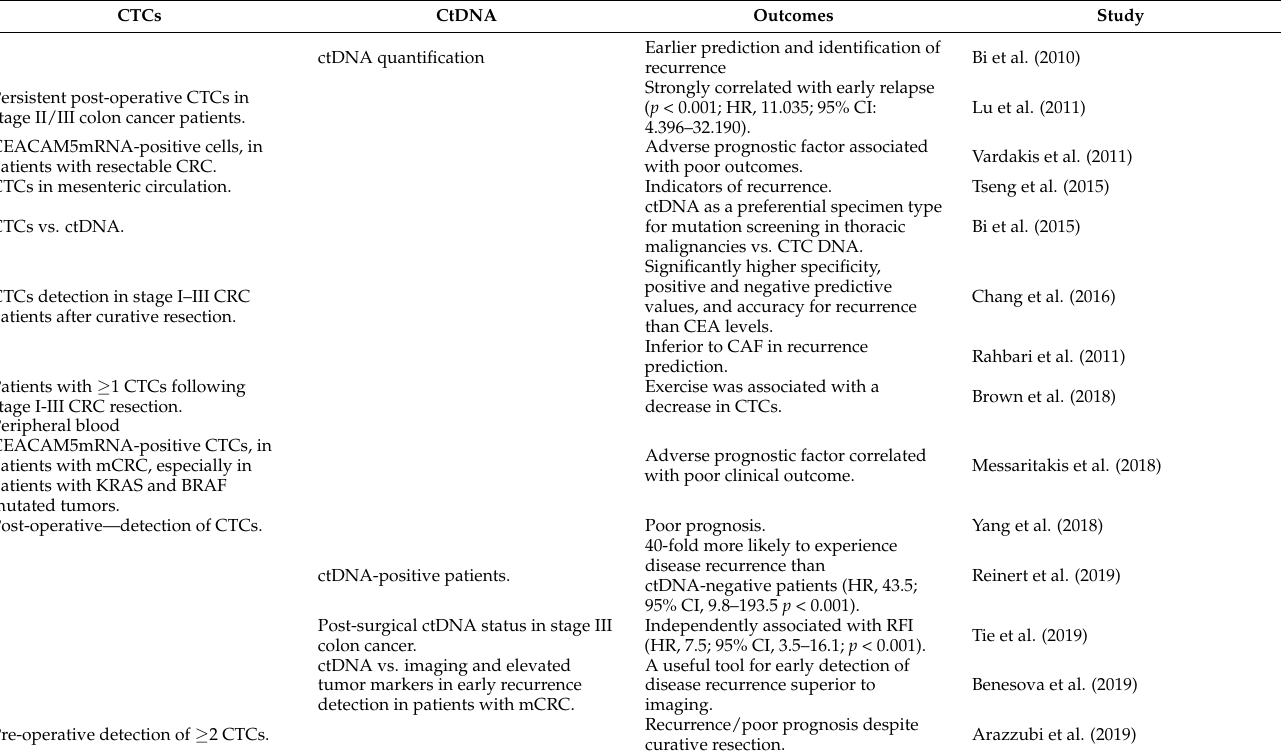
Table 2. Studies on CTCs and ctDNA regarding resectable